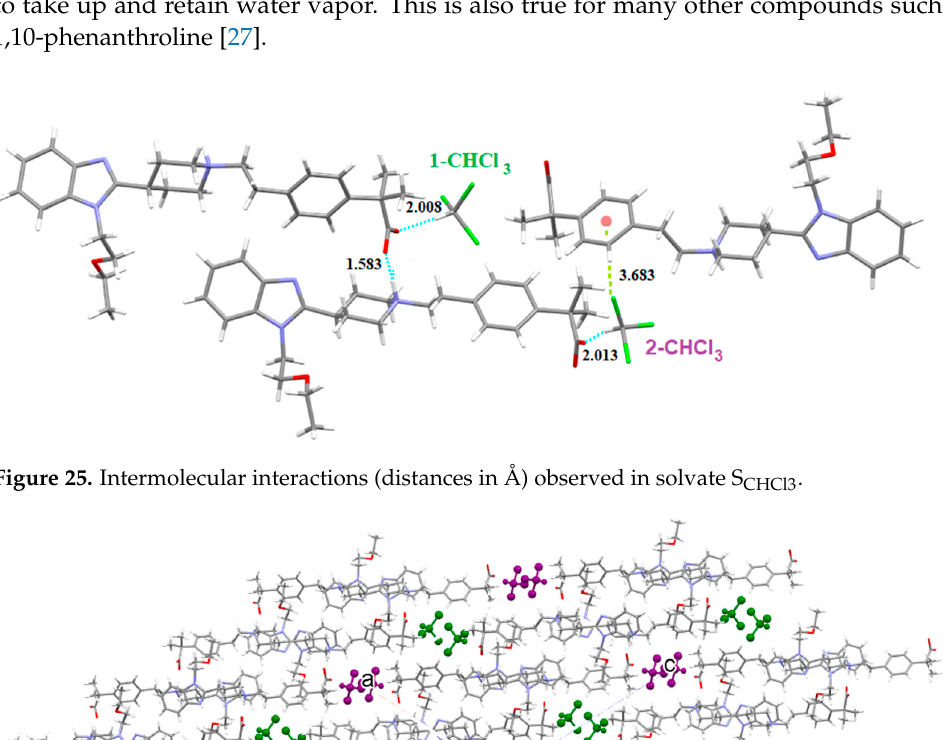
Figure 26. Crystal packing of S CHCl3 along the b axis. Green color for 1-CHCl 3 and purple color for 2-CHCl 3 .